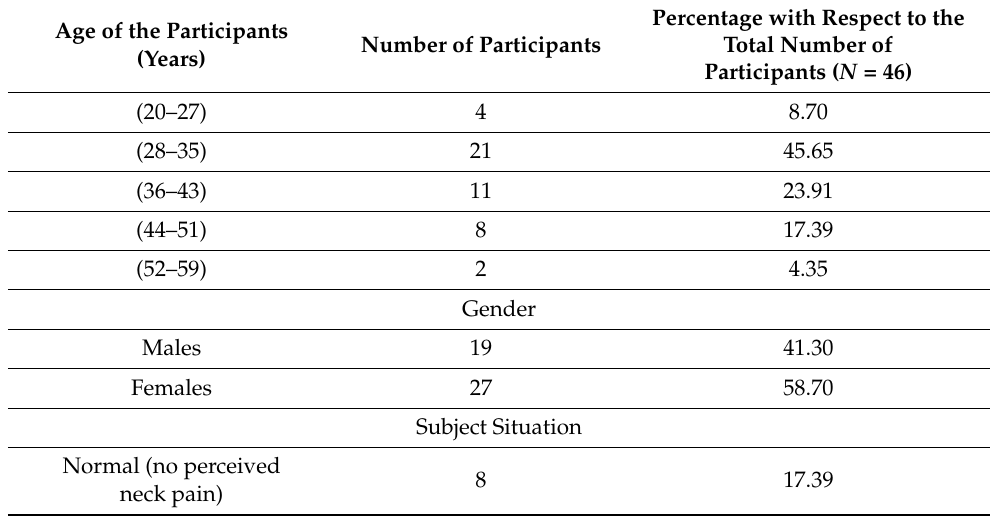
Table 3. Demographics of the patients participating in the study (total number of participants N =